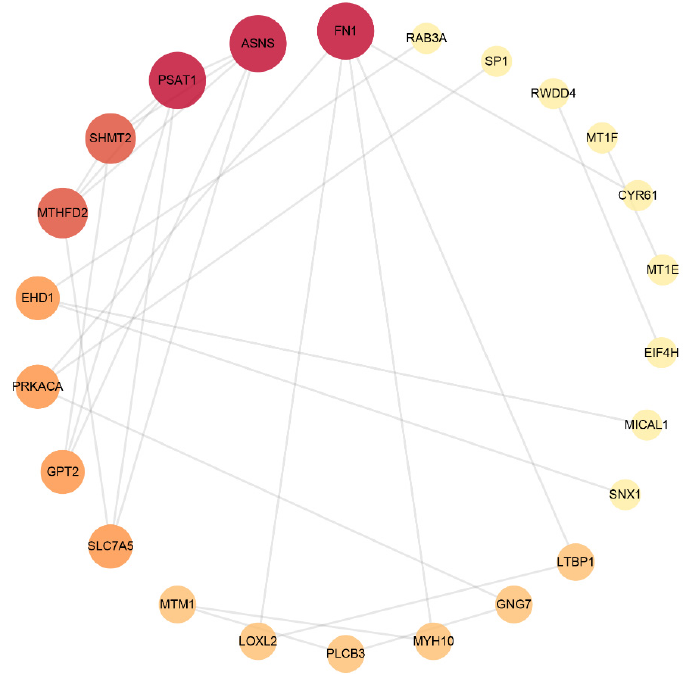
Figure 2. Protein–protein interaction network. The size and colour scales of the circle indicate the node degree centrality. FN1 (fibronectin); PSAT1 (phosphoserine aminotransferase); ASNS (asparagine synthetase); SHMT2 (serine hydroxymethyltransferase); MTHFD2 (bifunctional methylenetetrahydrofolate dehydrogenase/cyclohydrolase, mitochondrial); EHD1 (EH domain-containing protein 1); PRKACA (PKA C-alpha); GPT2 (alanine aminotransferase 2); SLC7A5 (large neutral amino acid transporter small subunit 1); PLCB3 (phospholipase C beta 3). Table 5. The relative parameters of the protein–protein interaction network.